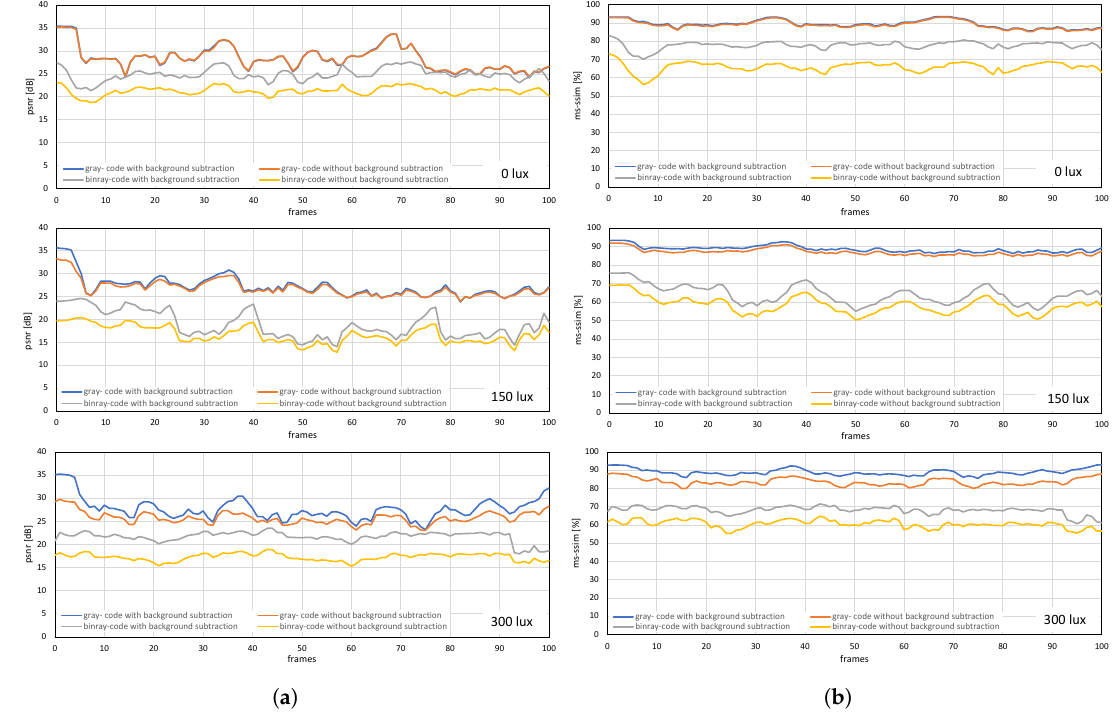
Figure 23. ( a ) PSNRs and ( b ) MS-SSIMs when USB camera video sequence is streamed with pure-binary-code and gray-code images on the plain background.